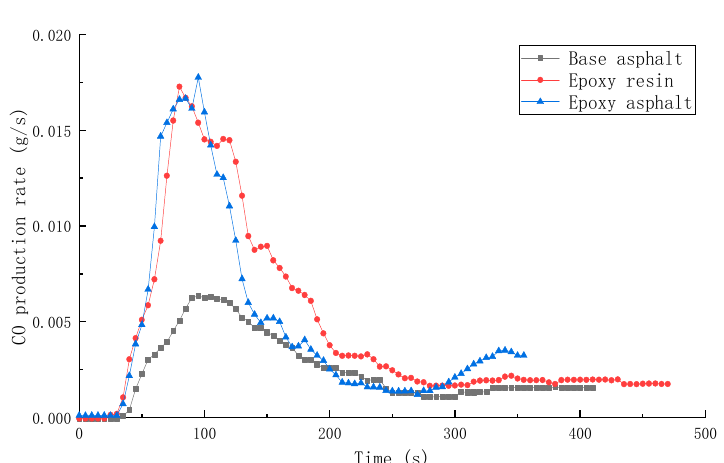
Figure 10. TSR of different materials.